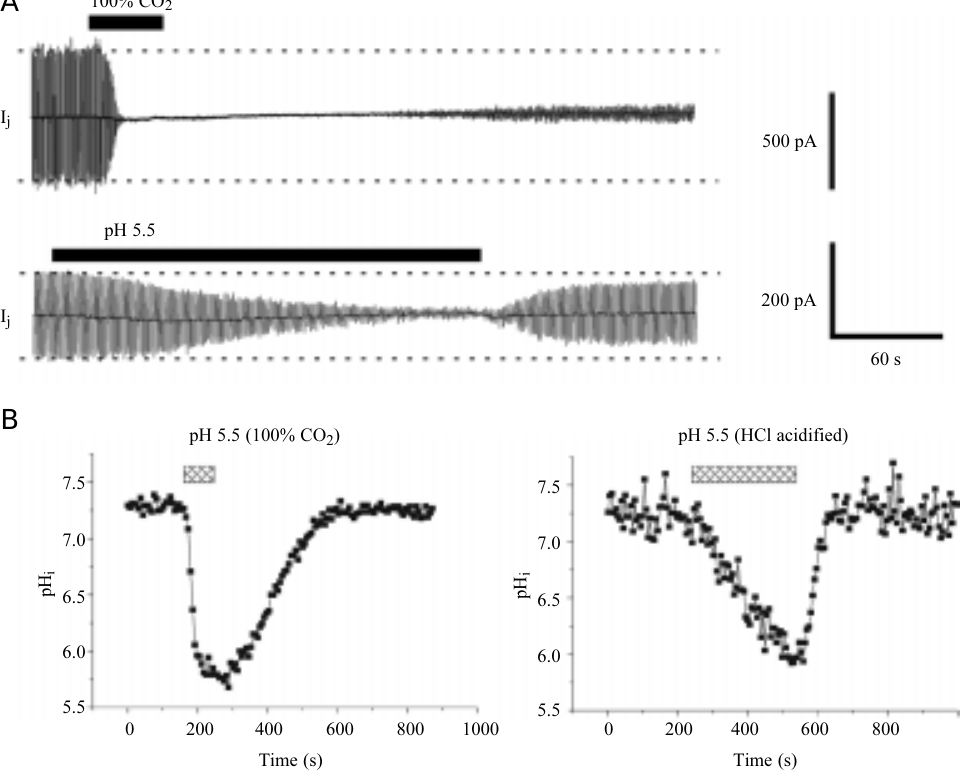
Figure 6 - Acidification-induced uncoupling in pairs of Cx46 transfected Neuro-2a cells. A , Whole-cell patch recordings of junctional current, I j , in response to a series of brief alternating V j steps of +30 and -30 mV. Com- parison of application of 100%